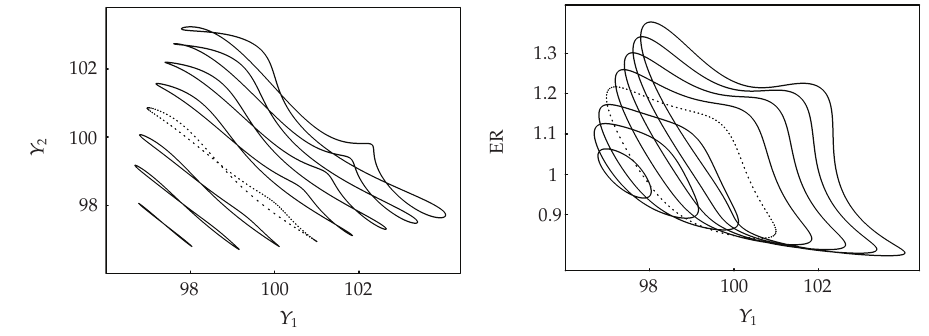
Figure 16: The bifurcating cycles for Z (cid:9) 35, δ (cid:9) 0 . 4, α (cid:9) 0 .